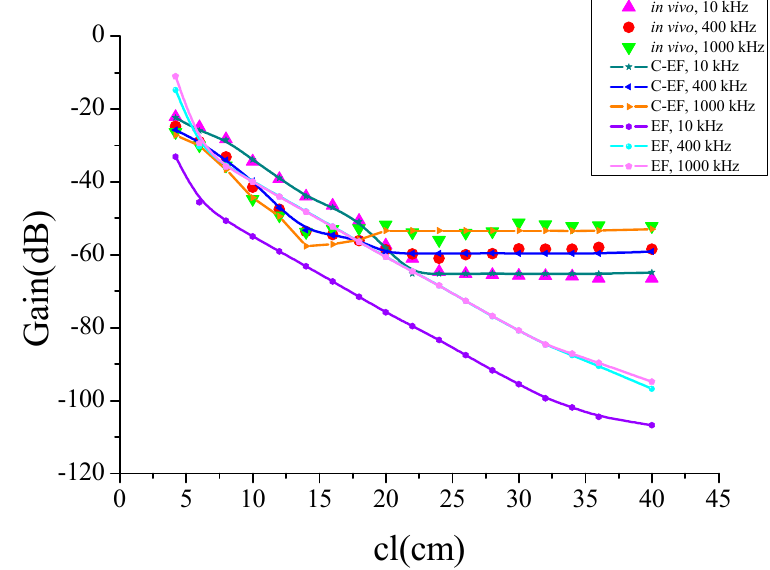
Figure 9. Mean values of the intra-body communication channel characteristics for the field-circuit model, electric field model and the body experiments, measured on 10 test subjects at different frequencies.